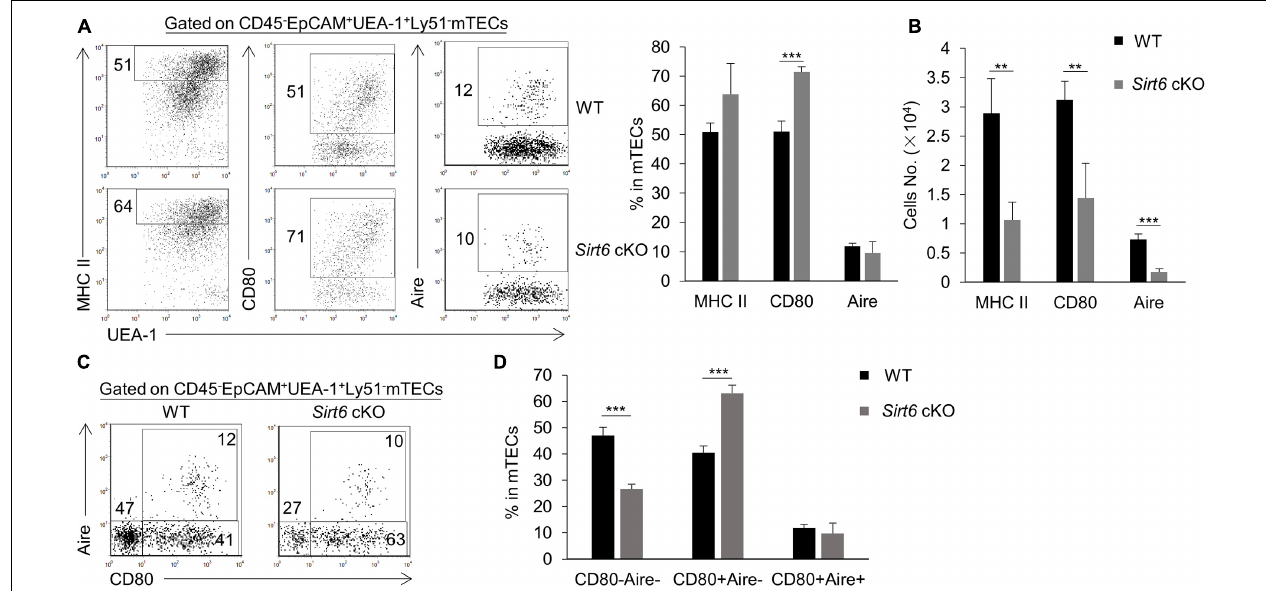
FIGURE 3 | The proportion of CD80 + mTECs specifically increases in Sirt6 cKO mice. (A) Representative flow cytometric profiles and frequencies of MHC II, CD80 and Aire expressed on mTECs of WT and Sirt6 cKO mice. (B) Cell numbers of MHC II high , CD80 + and Aire + mTECs of Sirt6 cKO mice and littermates. (C) Flow cytometry plots showed the mature stage by detecting the expression of CD80 and Aire. (D) The ratio statistics of different stages in the maturation of mTECs have been shown. N ≥ 4 per group. ** p < 0.01 and *** p < 0.001 (Student’s t